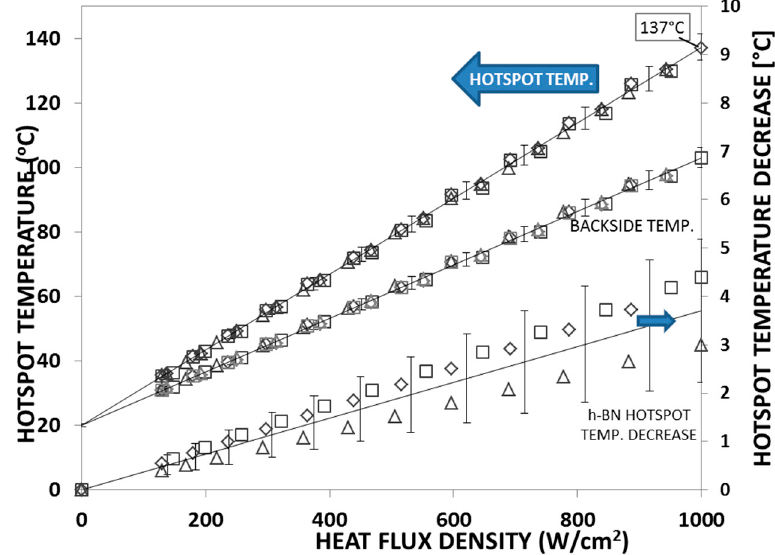
Figure 16. Temperature distribution across the hotspot test chip as captured by infrared camera for two di ff erent test structure designs: ( a ) new design; ( b ) old design. Reprinted with permission from Reference [46].